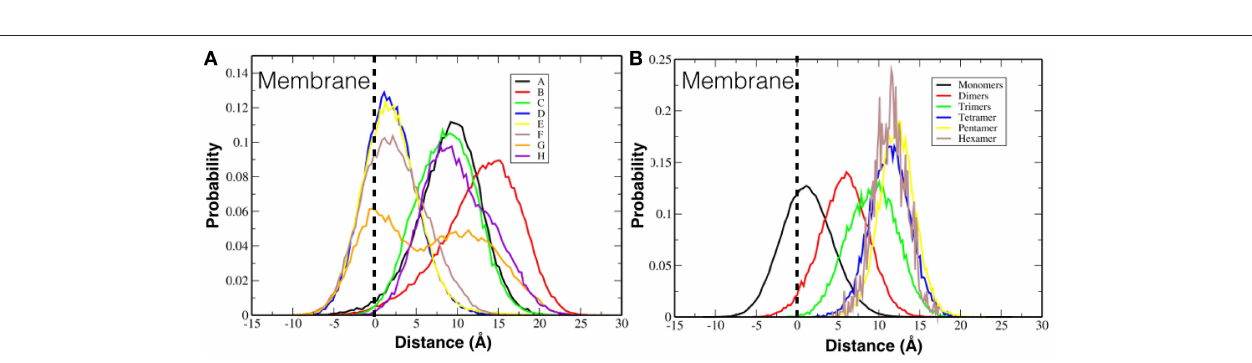
FIGURE 6 | Probability distribution of the positioning of FPs with respect to the membrane surface. (A) Probability distribution is calculated for each single TFP monomer. (B) Probability distribution is calculated for the oligomeric